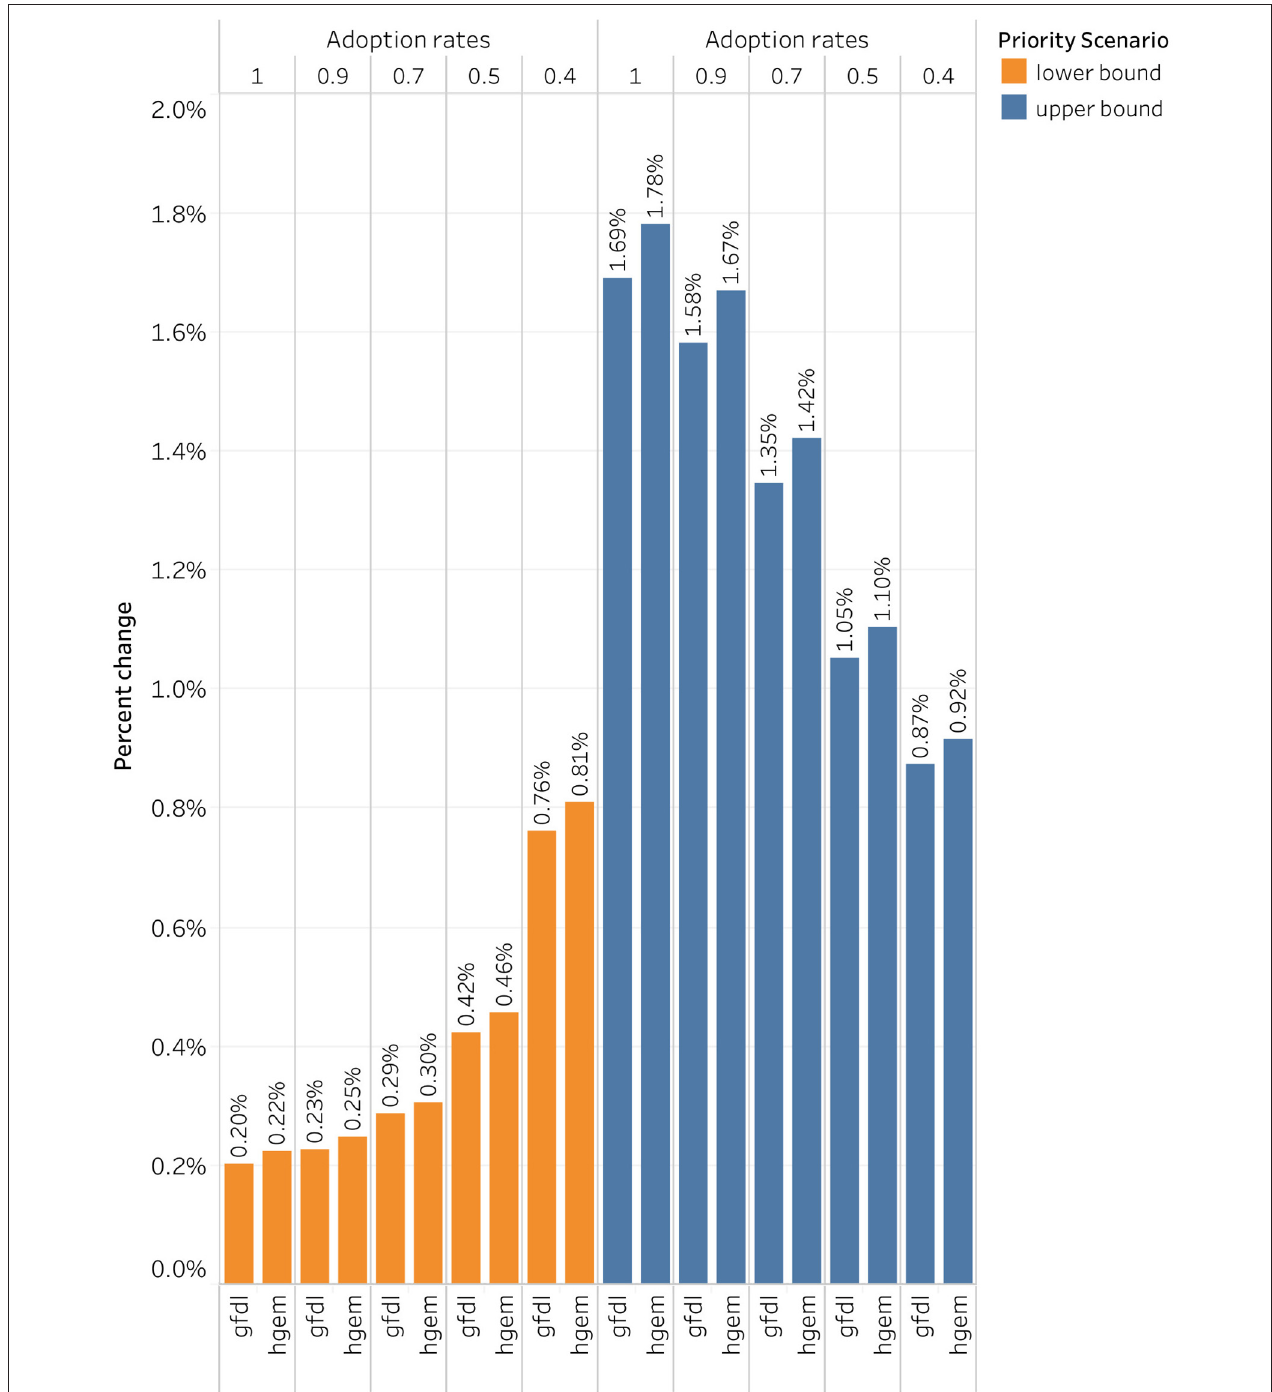
FIGURE 5 | Changes in cumulative fresh harvest weight of maize, rice and wheat across climate models and participation rates compared to BAU.